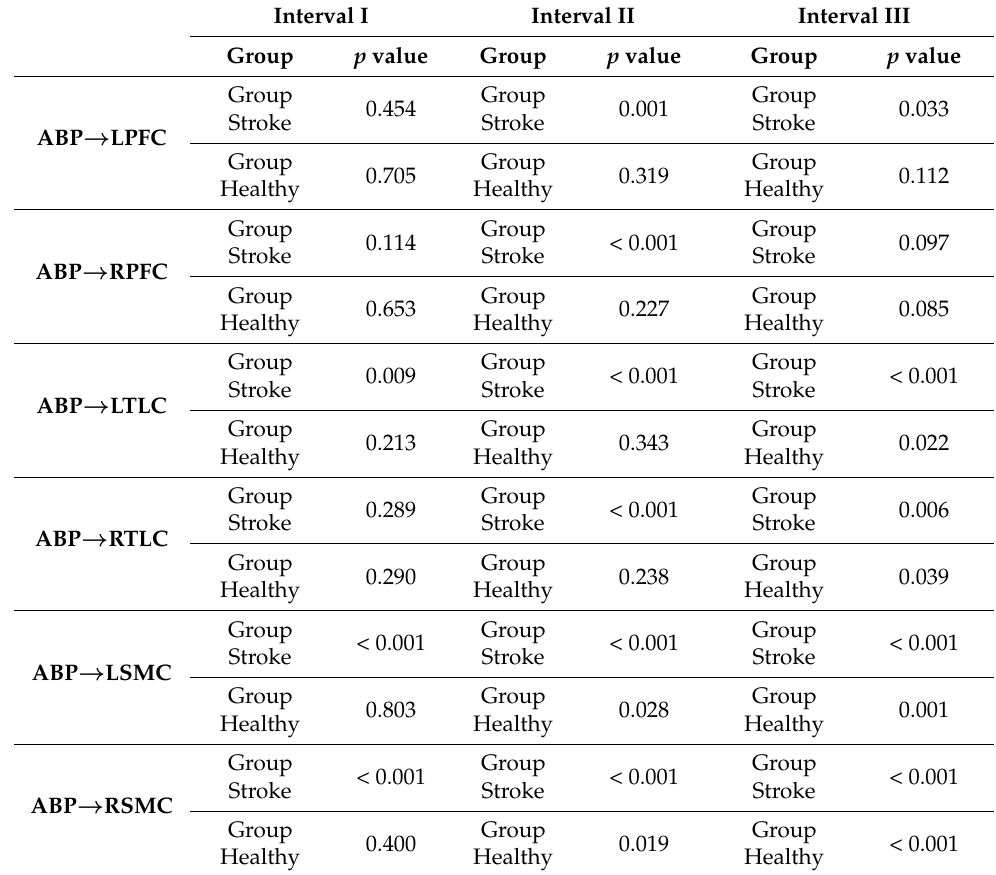
Table 3. Statistical significance results of the average differences of coupling strength values between the State_R and